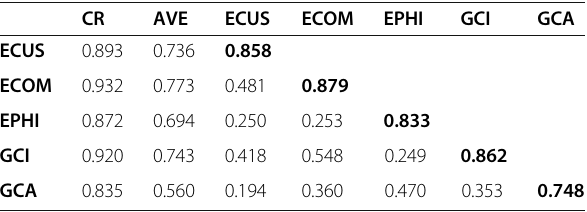
Table 3 Measures of convergent validity and discriminant validity